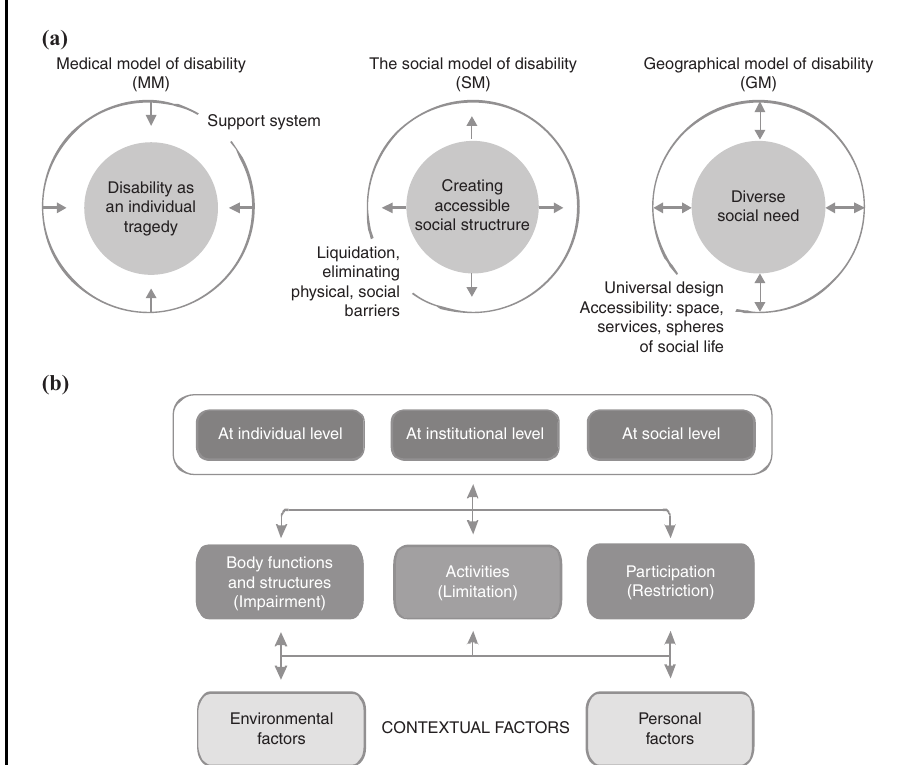
Figure 1 Models of disability: (a) medical, social, geographical; (b)